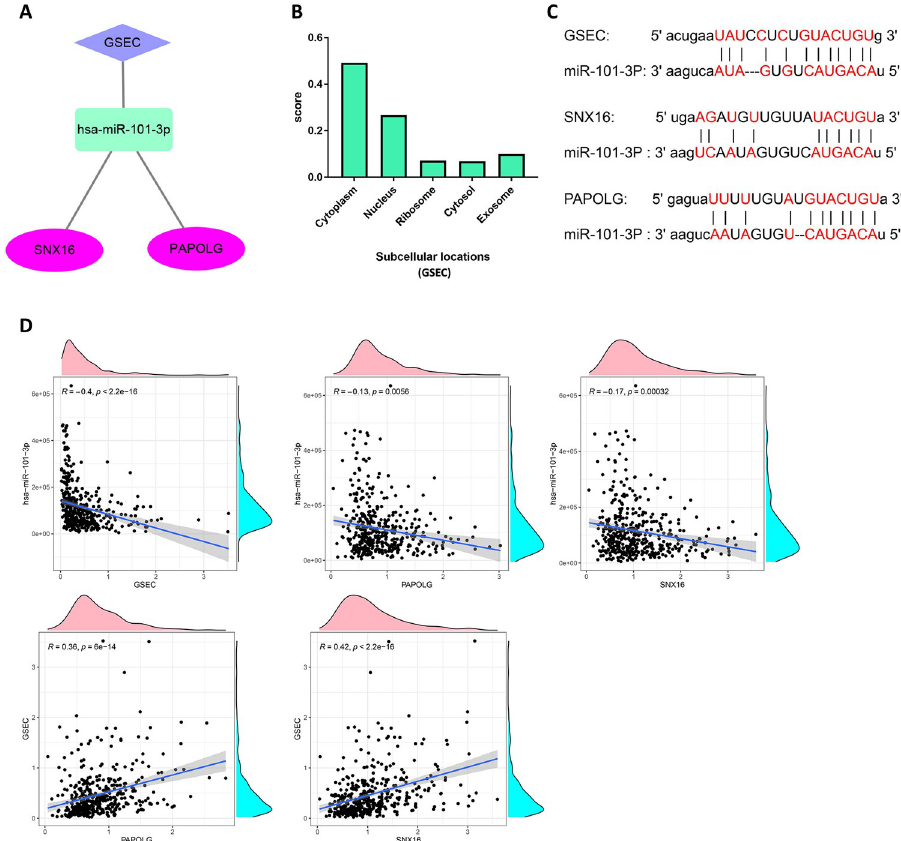
Fig 7. Construction of ceRNA network axis and correlation analysis. (A) ceRNA network axis GSEC/miR-101-3p/ SNX16/PAPOLG. (B) Prediction of GSEC localization in cells using lncLocator. (C) ENCORI database prediction of the action sites of miR-101-3p with GSEC, the miR-101-3p with SNX16, PAPOLG, respectively. (D) Correlation analysis between these four genes (GSEC, miR-101-3p, SNX16, PAPOLG) based on TCGA data.